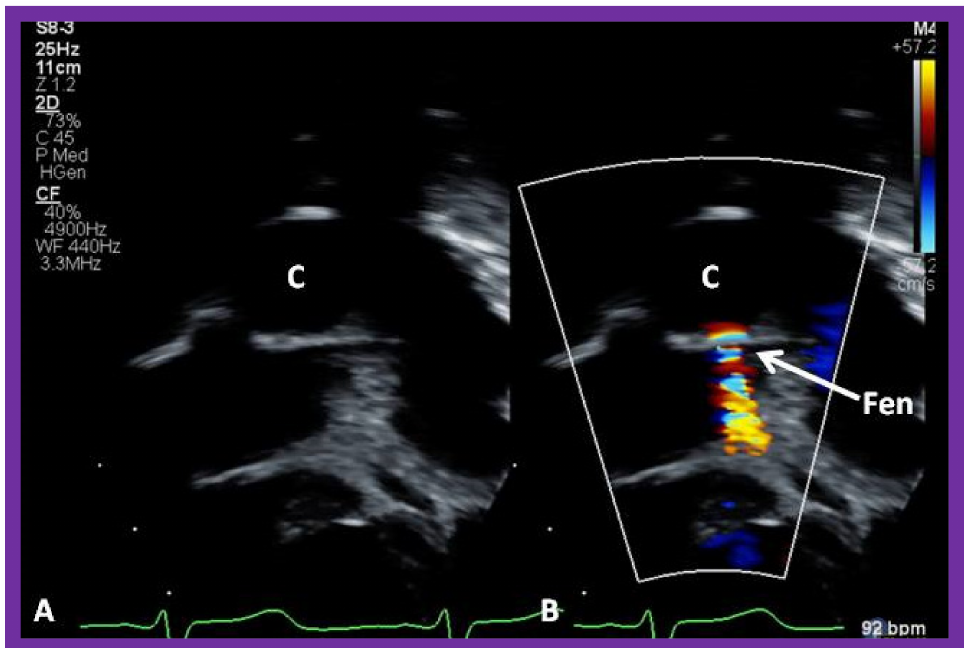
Figure 16. Echo images from an apical four chamber projection by 2D ( A ) and color flow ( B ) imaging demonstrating cross-sectional images of the conduit (C) in ( A , B ) and a fenestration (Fen) in ( B ). Note that the flow across the Fen is turbulent ( B ). Reproduced from Reference